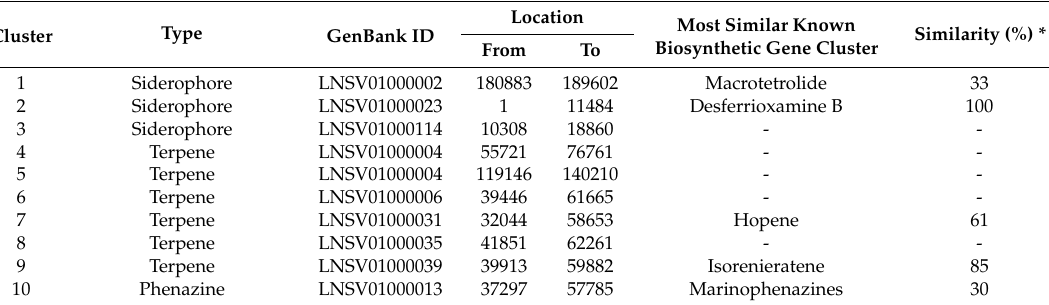
Table 1. Putative gene clusters for secondary metabolite in S. kanasensis